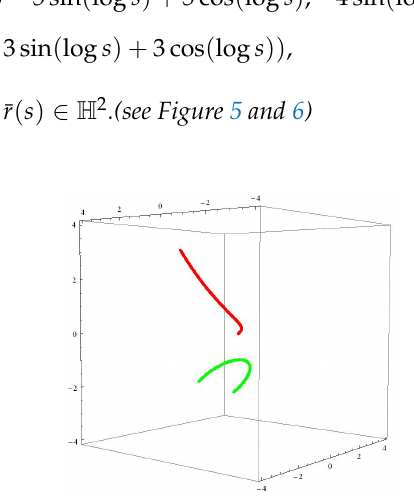
Figure 5. The positions of r (red) and ¯ r (green).